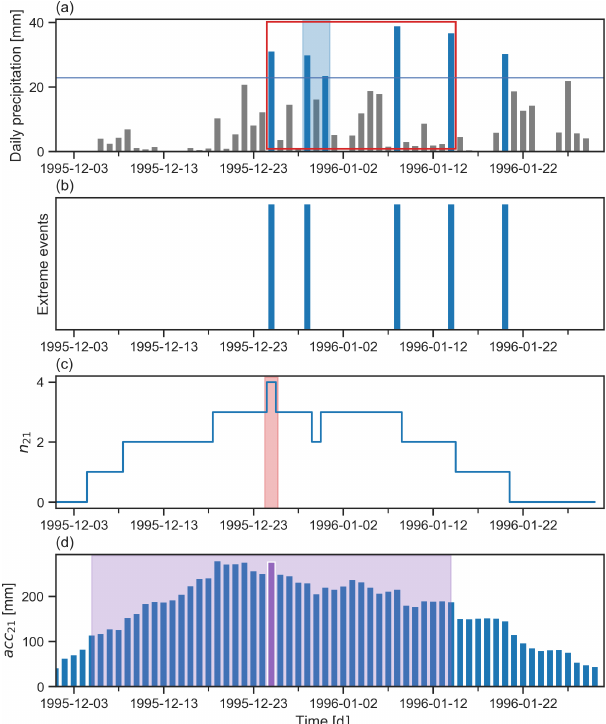
Figure 3. Schematic illustration of the identification of a sub- seasonal clustering episode with w = 21d. (a) Time series of daily precipitation with extreme precipitation days marked by blue bars; the horizontal blue line represents the threshold t (e.g. the 99th per- centile) defining the extreme events; the light blue shading high- lights a high-frequency cluster ( r = 2d), and the red rectangle de- notes the clustering episode identified using the information of pan- els (c) and (d) . (b) Series of binary events of extreme precipita- tion obtained after applying the declustering approach to the daily precipitation. (c) Number of extreme precipitation events in a run- ning (leading) time window of 21d ( n 21 ) based on the time series in panel (b) ; the light red shading indicates the day with the largest n 21 . (d) Precipitation accumulation in a running (leading) time win- dow of 21d (acc 21 ) derived from the time series of panel (a) ; the purple bar denotes the day with the largest acc 21 among the days with highest n 21 ; this day is the starting day of the selected clus- tering episode; all days within the light purple shading are removed from the initial time series in the next step of the selection algo-